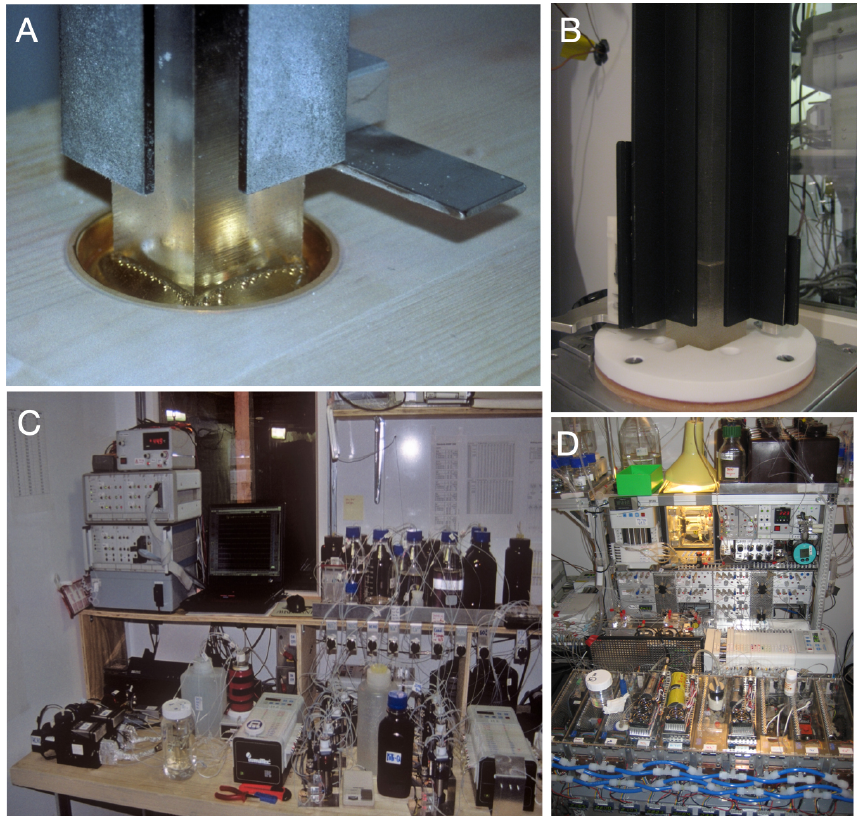
Figure 3. Pictures of the meltheads and analysis systems used for the NGRIP and NEEM ice cores. Panels (a) and (c) show the NGRIP melthead and system during the NGRIP field deployment, panels (b) and (d) the melthead and system in use at NEEM. Drawings of the melthead designs are provided in Sigg et al. (1994) for NGRIP and in Bigler et al. (2011) for NEEM, respectively. (All pictures by Matthias